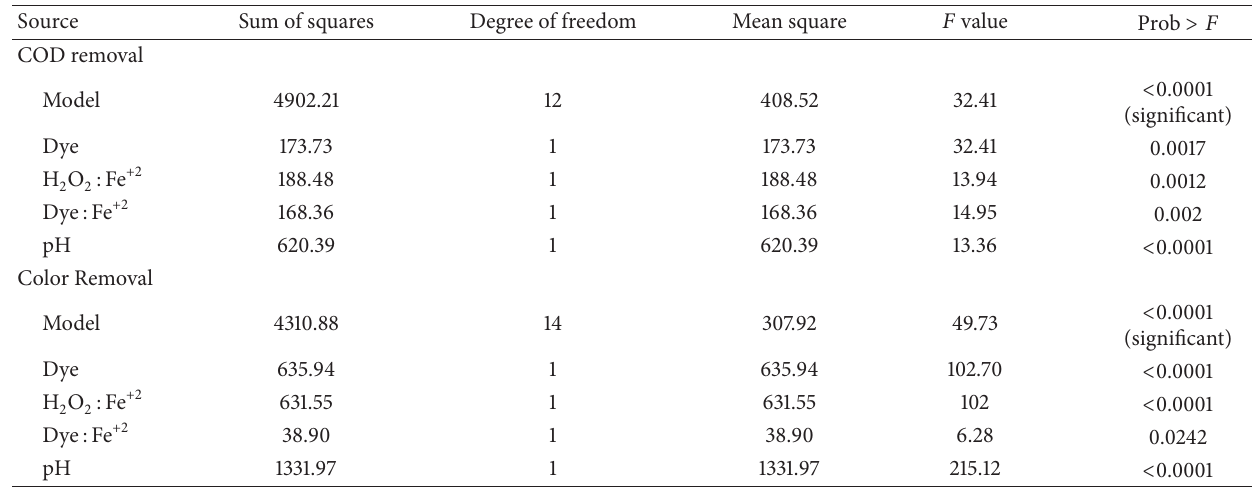
Figure 4: Predicted and actual value for (a) COD and (b) decolorization efficiency. Table 3: ANOVA results for